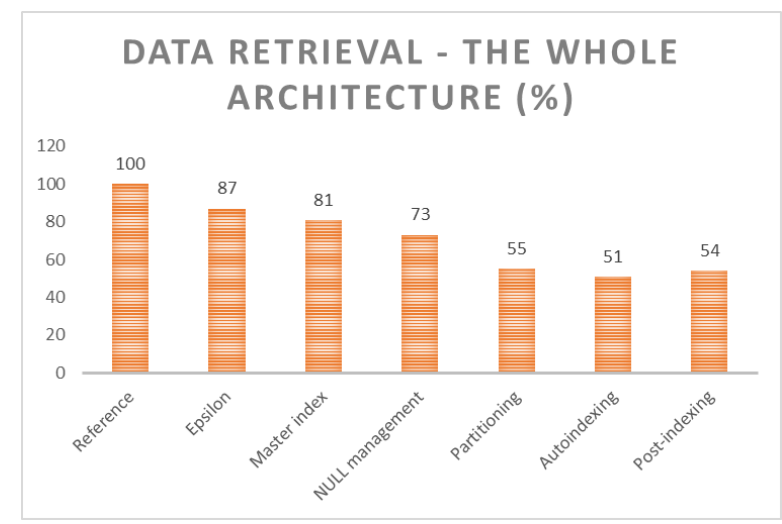
Figure 25. Whole system modularization—data retrieval performance.